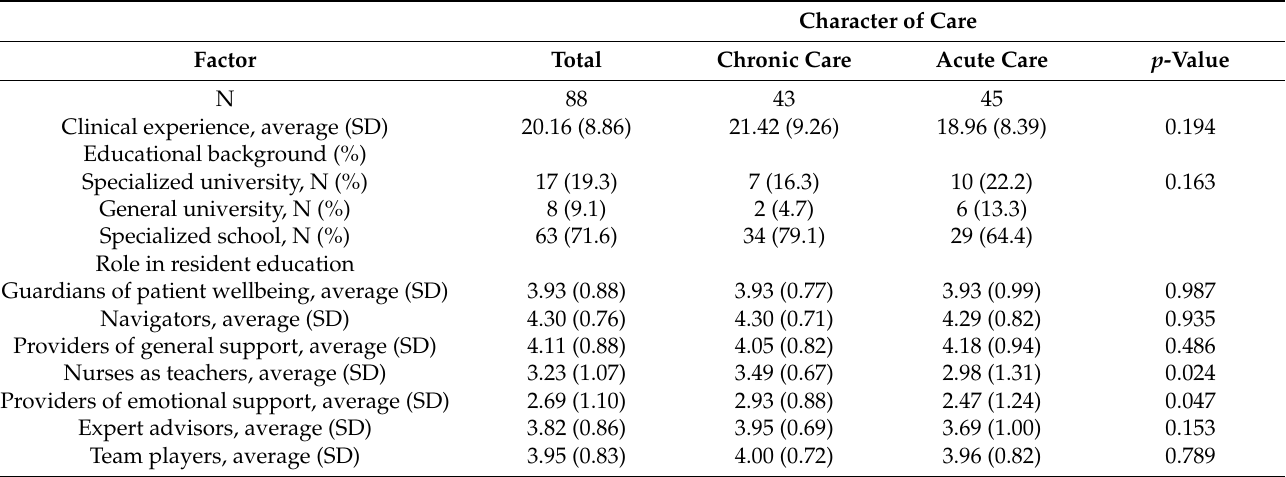
Table 1. Participants’ demographics and the results of the questionnaire on nurses’ roles in family medicine education.